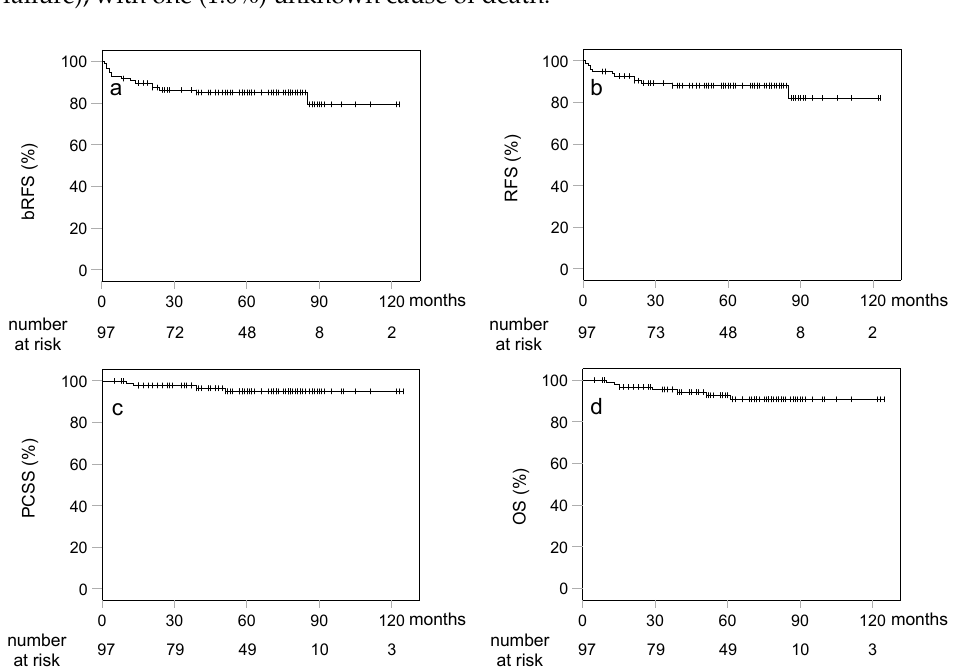
Figure 1. Kaplan–Meier curves for ( a ) biochemical relapse-free survival (bRFS); ( b ) relapse-free survival (RFS); ( c ) overall survival (OS); ( d ) prostate cancer-specific survival (PCSS). Table 3. Univariate analysis for factors associated with bRFS and